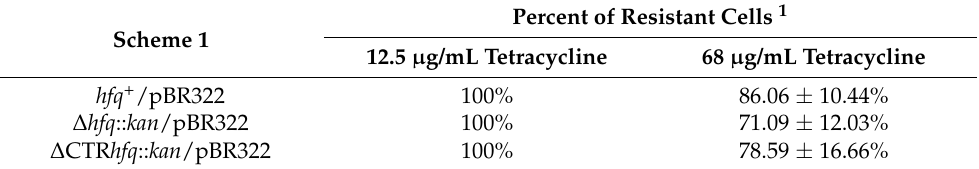
Table 6. Resistance of E. coli hfq +, ∆ hfq :: kan , and ∆ CTR hfq :: kan strains bearing the pBR322 plasmid to different concentrations of tetracycline.